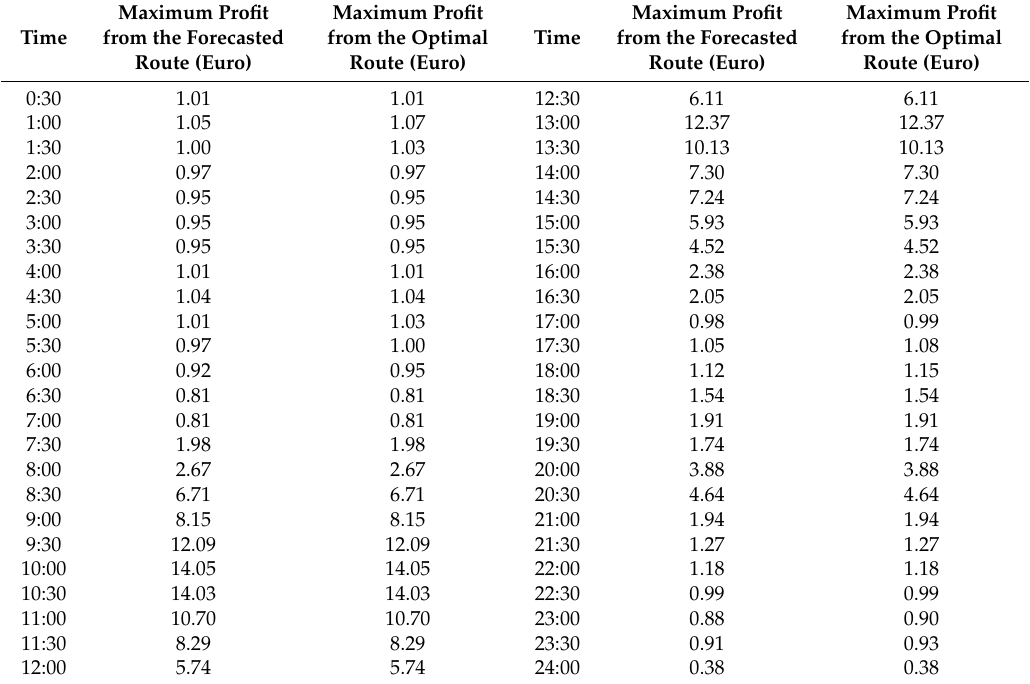
Table 3. Maximum profits of the forecasted route and optimal